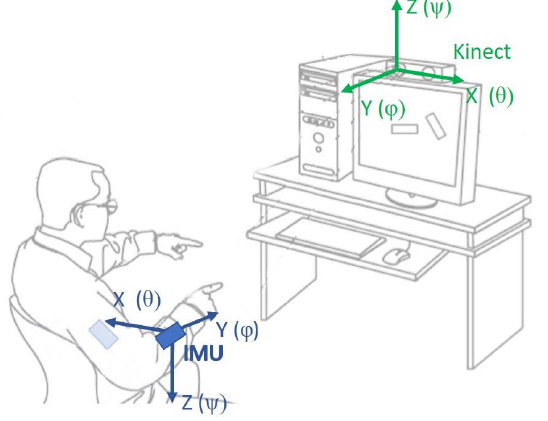
Figure 10. Measurement devices’ coordination